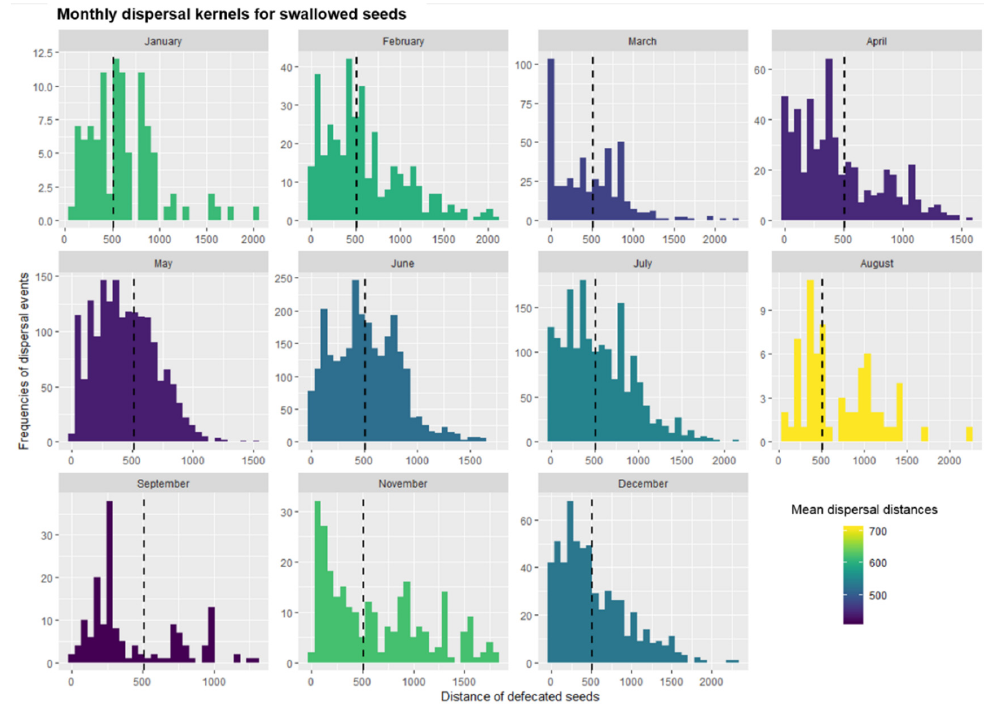
Figure 2. Simulated monthly total dispersal kernels for swallowed seeds by the northern pigtailed macaques inhabiting the degraded forest fragment of Sakaerat. The dash line represents the total mean dispersal distance = 511 m.